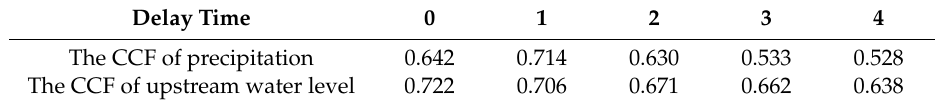
Table 2. The cross-correlation function (CCF) between rainfall, upstream and downstream